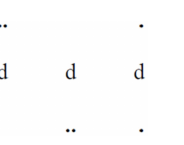
Figure 1. Examples of d2 mean